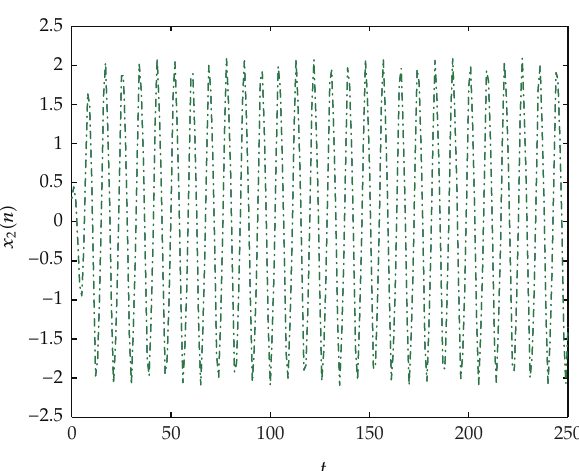
Figure 6: An invariant closed circle bifurcates from equilibrium (cid:2) 0 , 0 (cid:3) . The initial value and parameter D are (cid:2) 2 , 3 (cid:3) and 14 / 3, respectively.